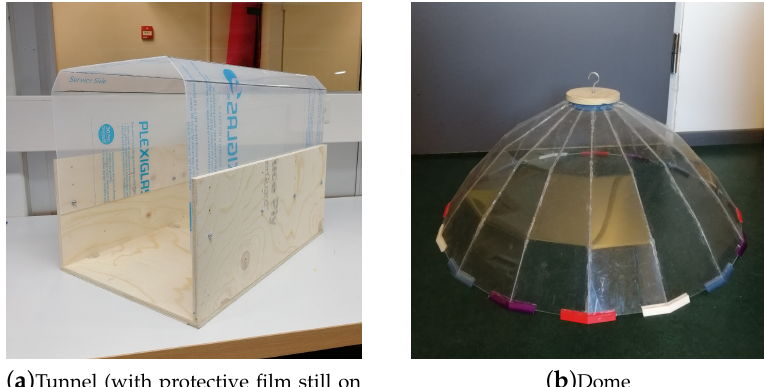
Figure 1. The initial non-functional prototypes.